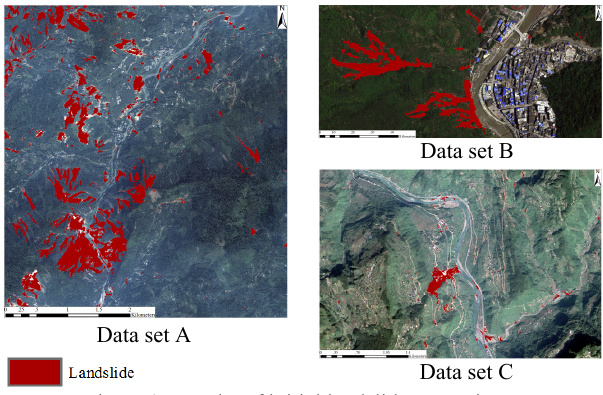
Figure 3. Results of initial landslide extraction